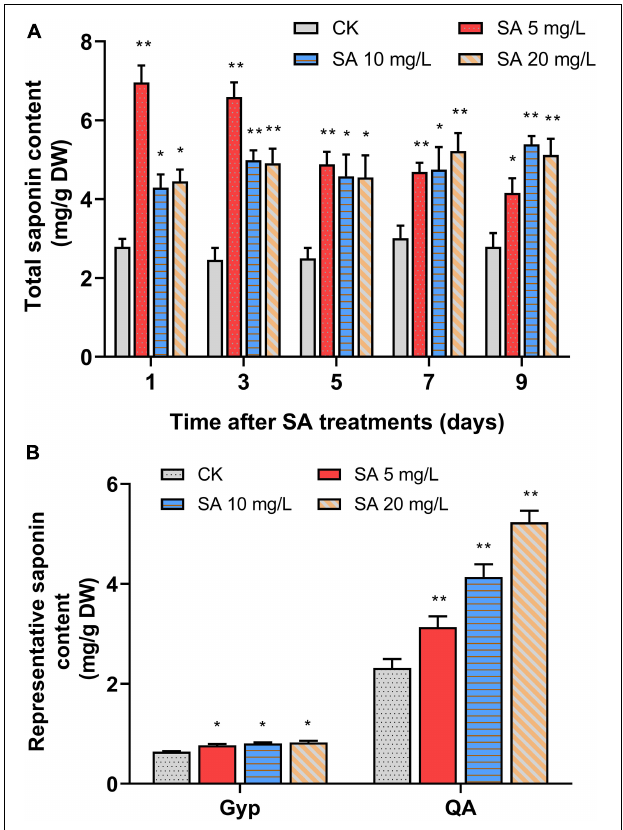
FIGURE 1 | Effects of SA elicitors on triterpenoid saponin production in P. tunicoides hairy root cultures. (A) The total saponin productions in hairy root cultures of control (CK) and elicited groups by 5, 10, and 20 mg/L SA for 1, 3, 5, 7, and 9 days. (B) The gypsogenin (Gyp) and quillaic acid (QA) contents in hairy root cultures of CK and elicited groups by 5, 10, and 20 mg/L SA for 1 day. The values represent the mean value ± SE from three biological replicates. *, ** Indicate significant differences in comparison with values of CK at P < 0.05 and P < 0.01 level ( t -test),